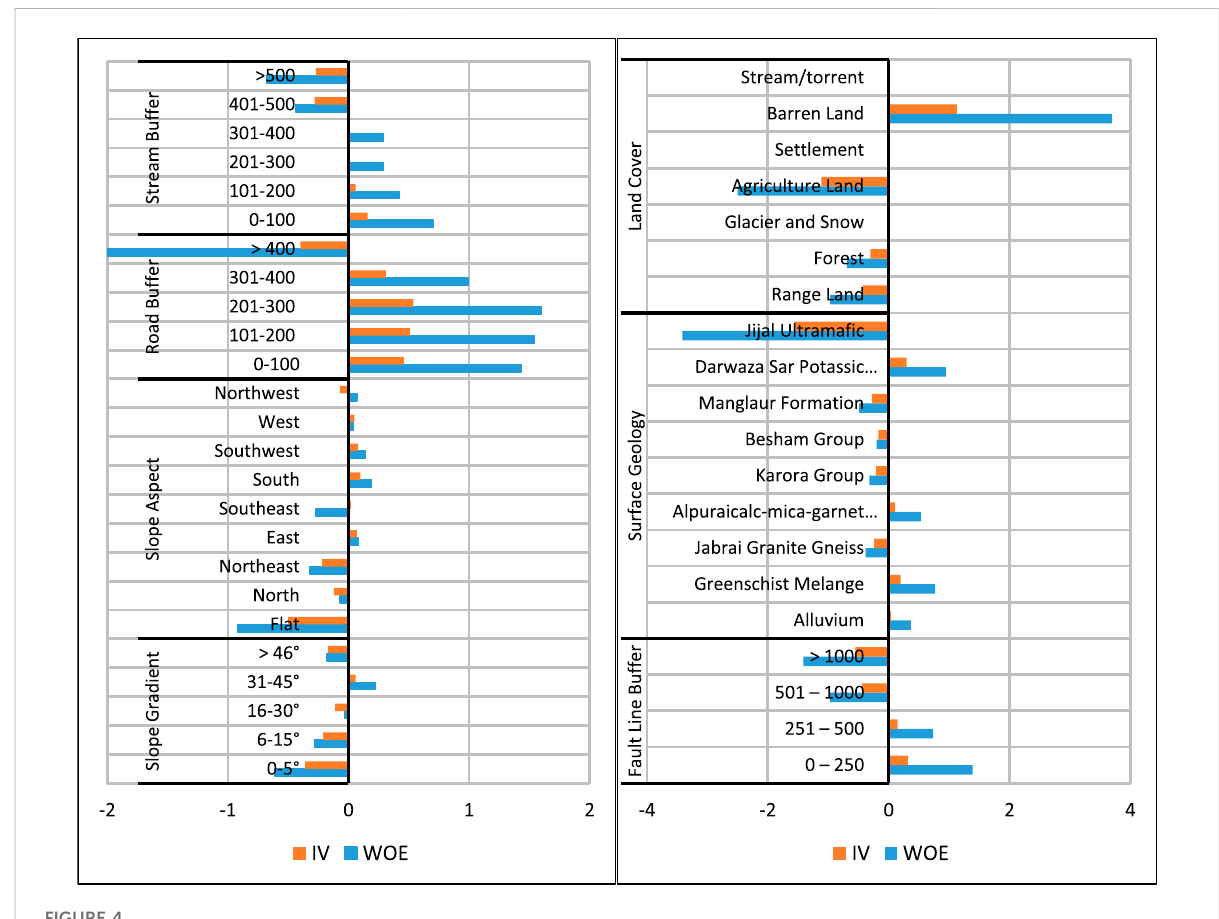
FIGURE 4 Shahpur valley, the calculated weight of each class of causal